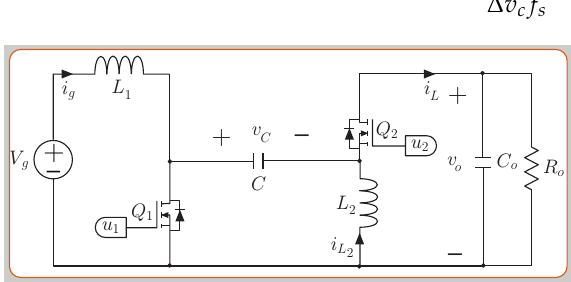
Figure 1. Topology of the SEPIC